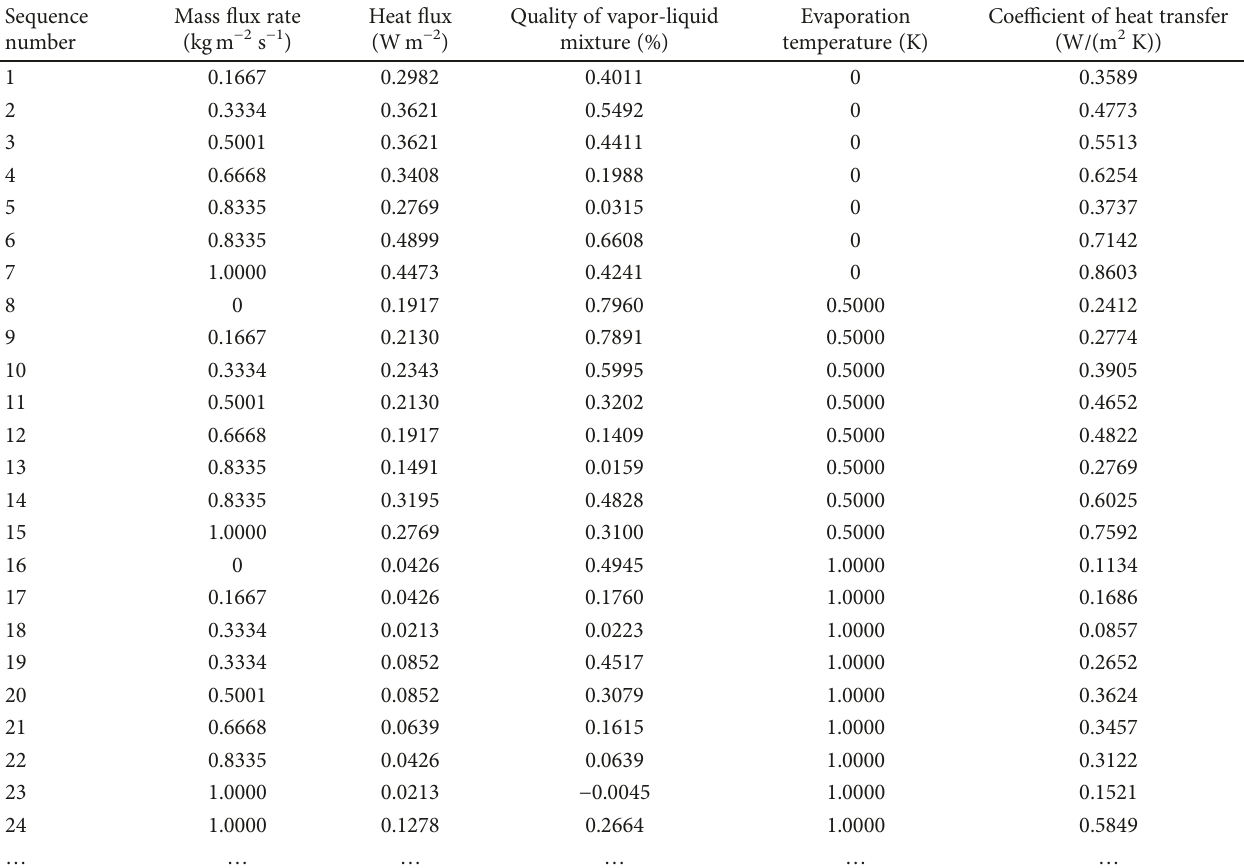
Table 5: Some of the experimental data after being